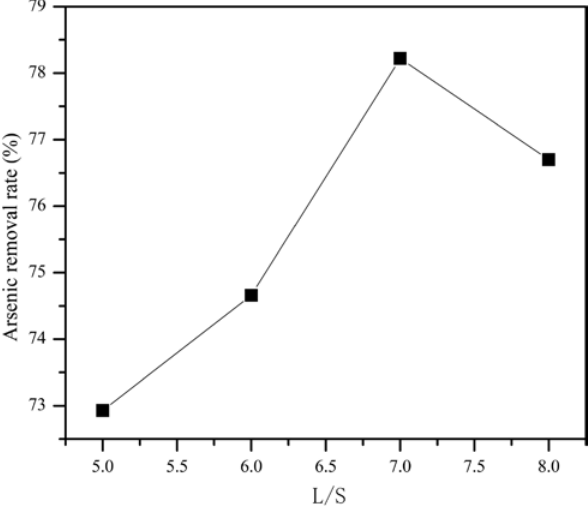
Figure 3: Effect of liquid-to-solid ratio on arsenic removal rate.